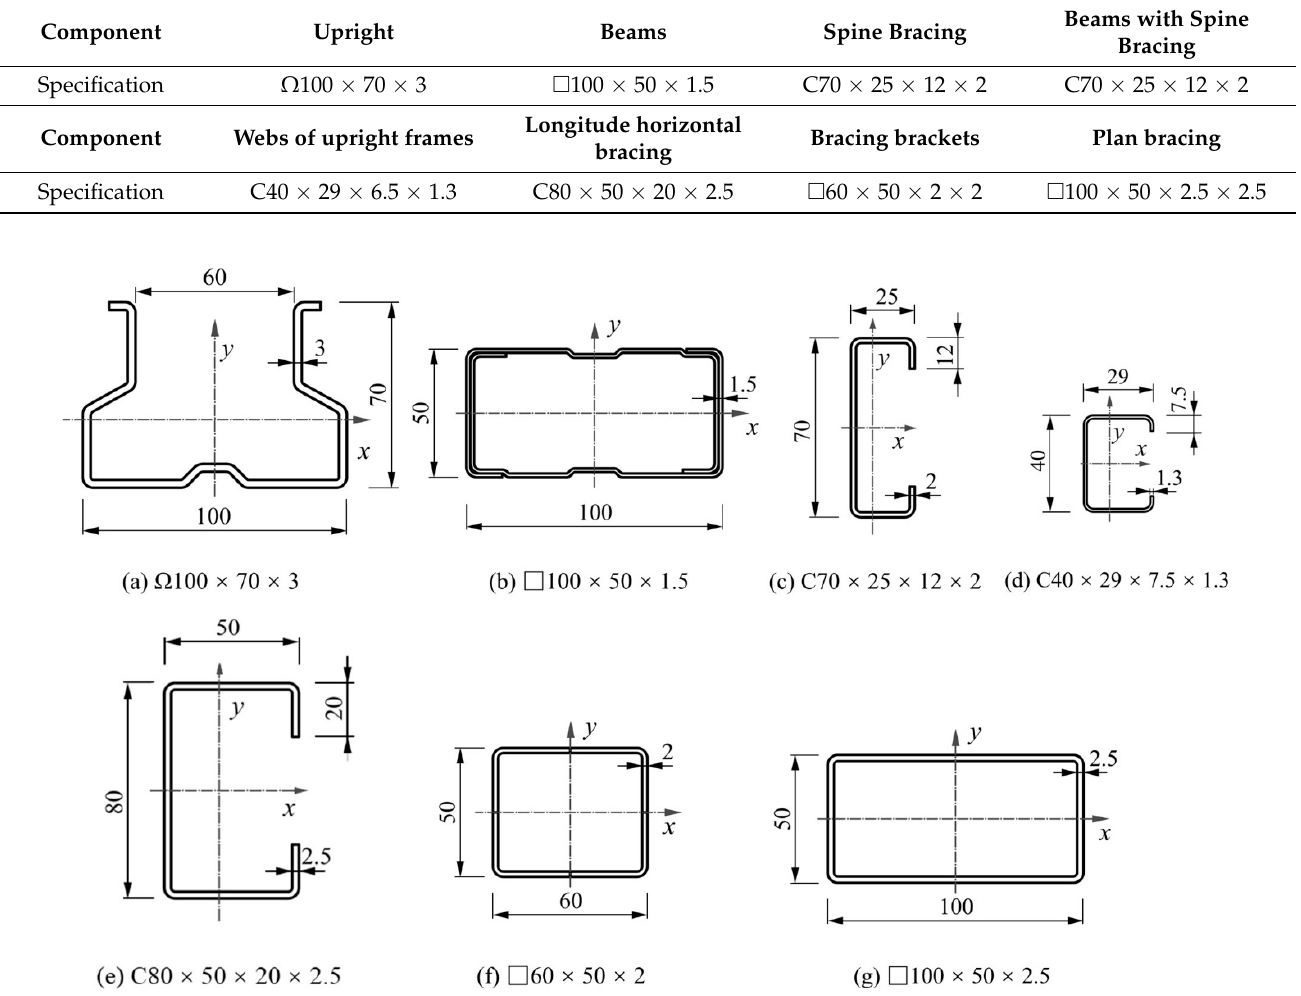
Table 1. Model component specifications.